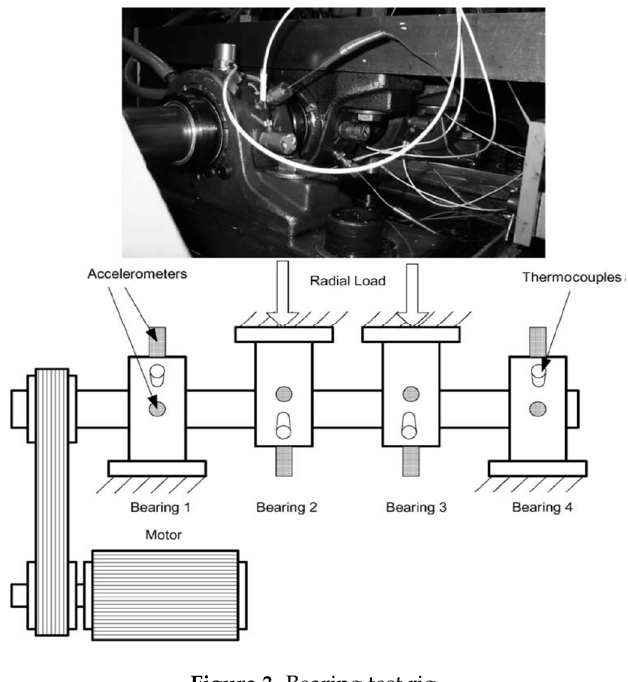
Figure 3. Bearing test rig. Table 1. Test sample.